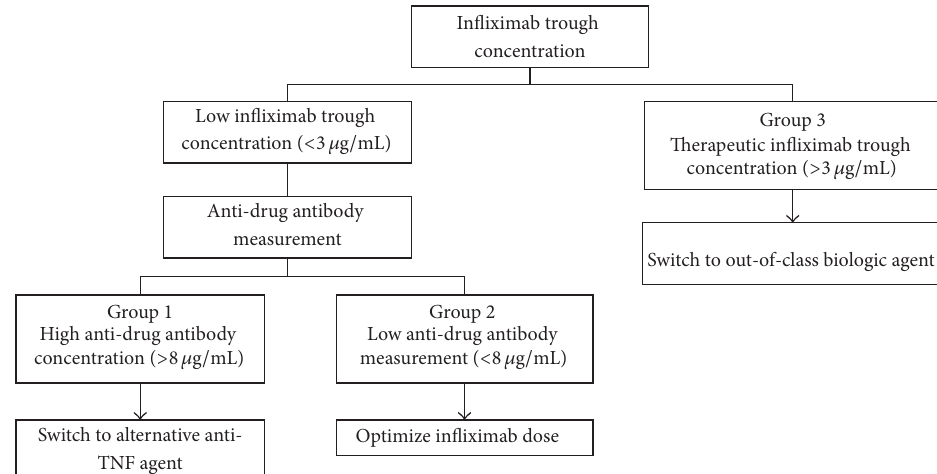
Figure 1: Therapeutic drug monitoring decision algorithm in inflammatory bowel disease patients on infliximab with concerns for loss of